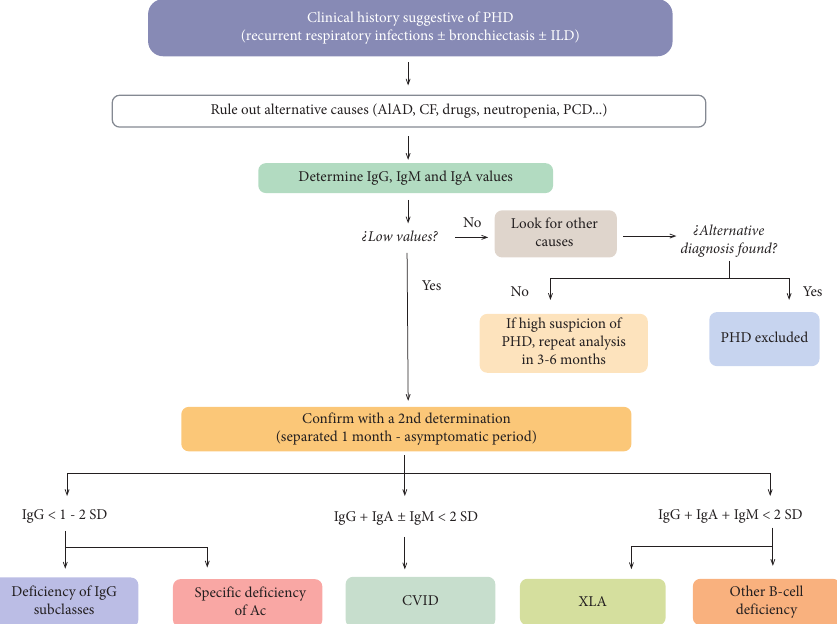
Figure 1: Diagnostic approach to primary humoral deficiencies in patients with respiratory symptoms (modified from Berger et al.) [50]. A1AD, alpha-1-antitrypsin deficiency; Ac, antibodies; CF, cystic fibrosis; CVID, common variable immunodeficiency; ILD, interstitial lung diseases; PCD, primary ciliary dyskinesia; PHD, primary humoral deficiency; SD, standard deviation; XLA, X-linked